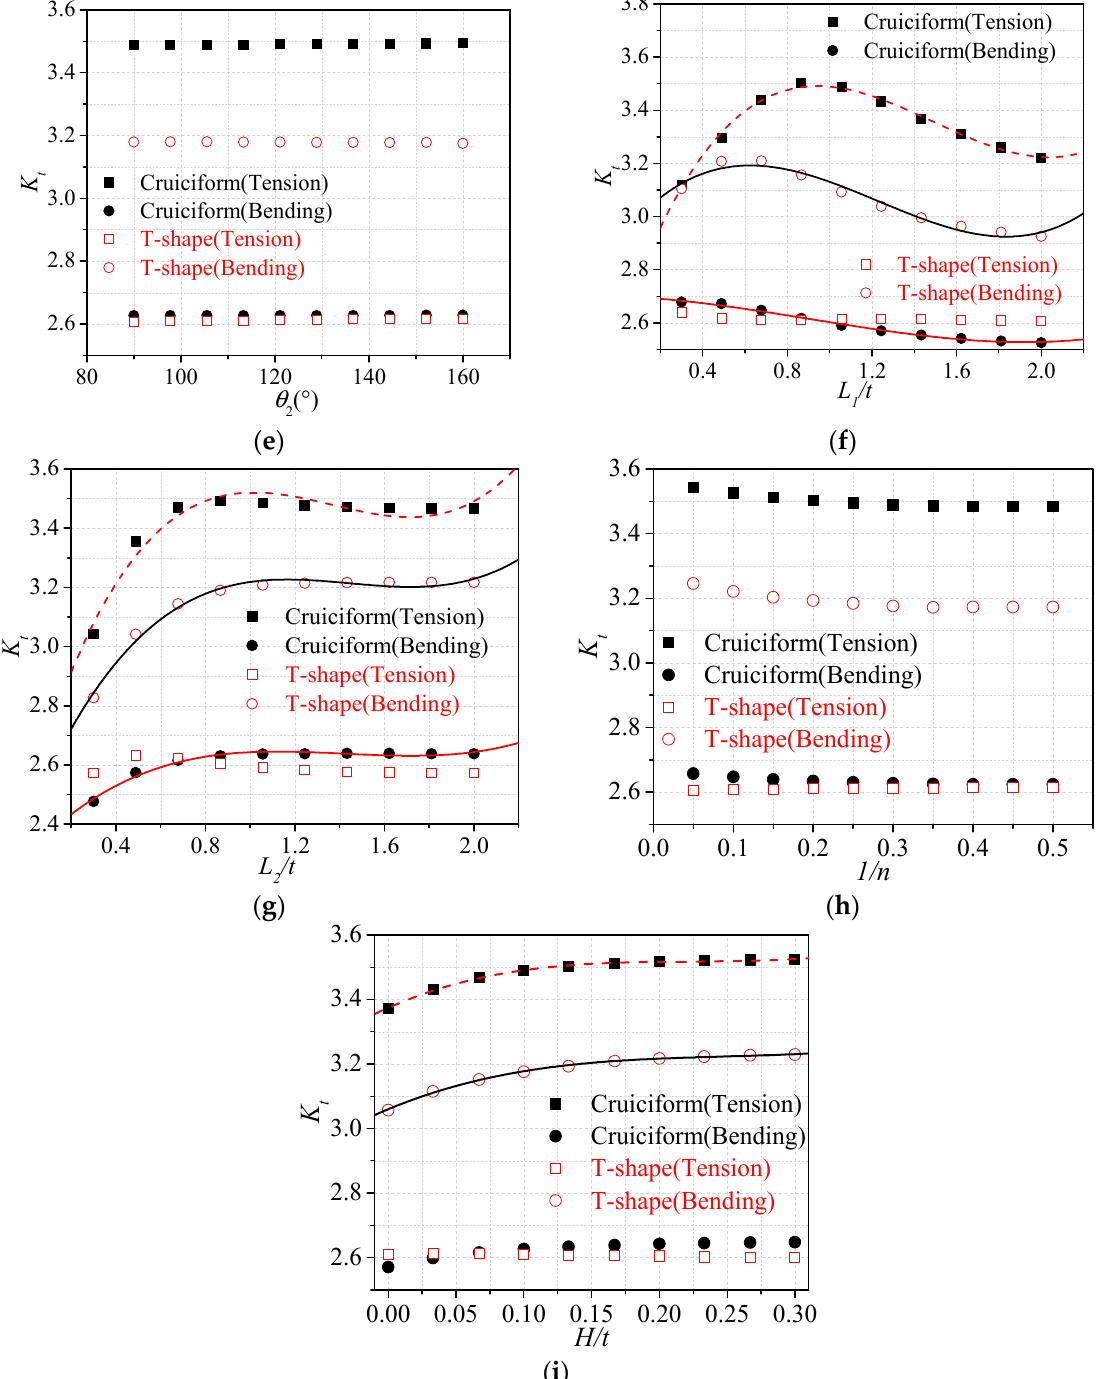
Figure 6. Accuracy of existing formulae: ( a ) stiffener thickness, T/t ; ( b ) bottom weld toe radius, r 1 /t ; ( c ) top weld toe radius, r 2 / t ; ( d ) bottom flank angle, θ 1 ; ( e ) top flank angle, θ 2 ; ( f ) bottom weld leg length, L 1 /t ; ( g ) top weld leg length, L 2 /t ; ( h ) salient point position, 1/n ; ( i ) hump height, H/t .